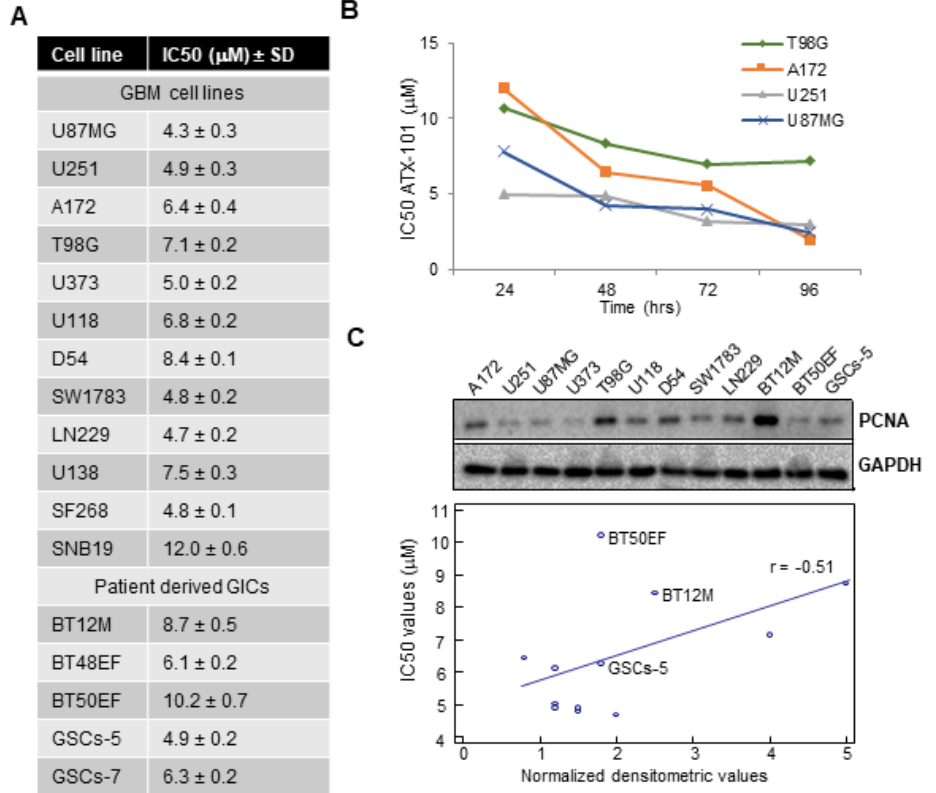
Figure 1. ATX-101 inhibits cell proliferation of GBM and GICs cells in vitro. ( A ) Twelve GBM cell lines and 5 GICs were examined for viability after treatment with ATX-101 (0.1–10 µ M). For the five GICs cell lines, the evaluation of cell proliferation was made by using sphere formation assay at clonal growth analyzed after 21 days. IC50 values are calculated for 12 GBM cell lines and 5 GICs at 72 h. ( B ) IC50 values for ATX-101 determined for 4 GBM cell lines over 96 h. ( C ) Upper panel: Western blots showing PCNA and GAPDH expression levels in 9 GBM and 3 GICs cell lines. Uncropped Western blots are shown in Supplementary Figure S2. In the lower panel, PCNA levels normalized against GAPDH were plotted against IC50s. GICs are marked in the graph and the r value ( − 0.51) is depicted in the graph.